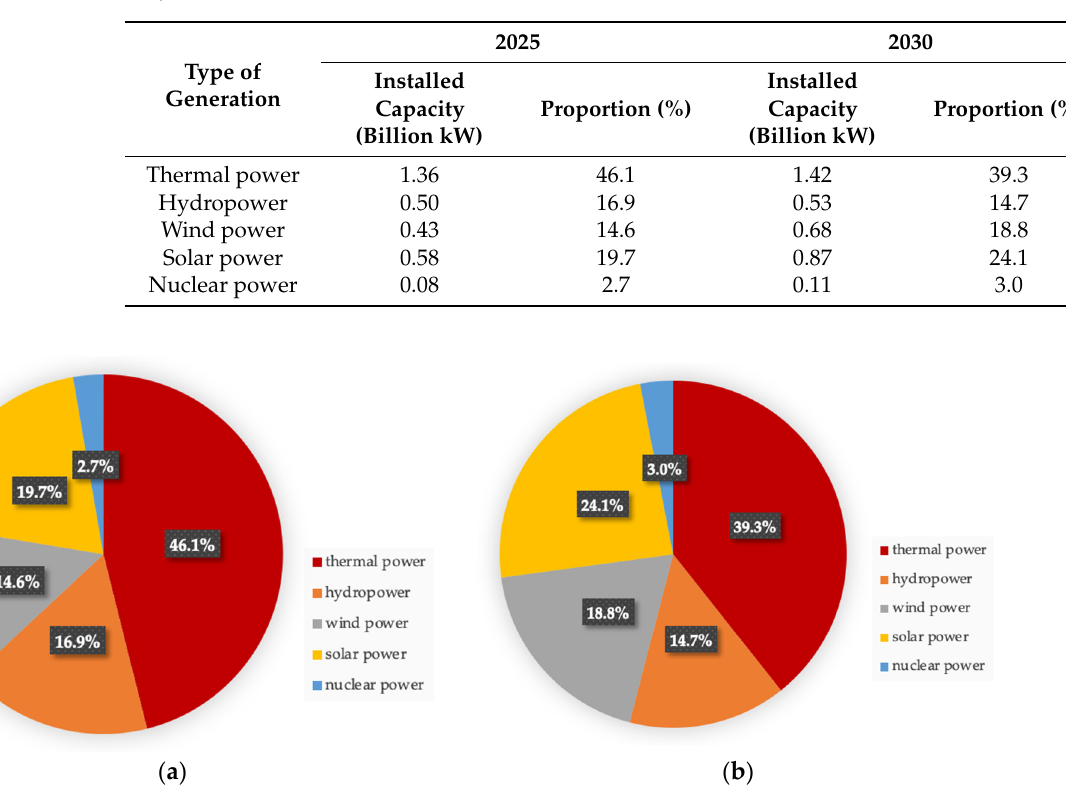
Table 6. Installed capacity of various power generation types in extreme weather conditions (billion kW).